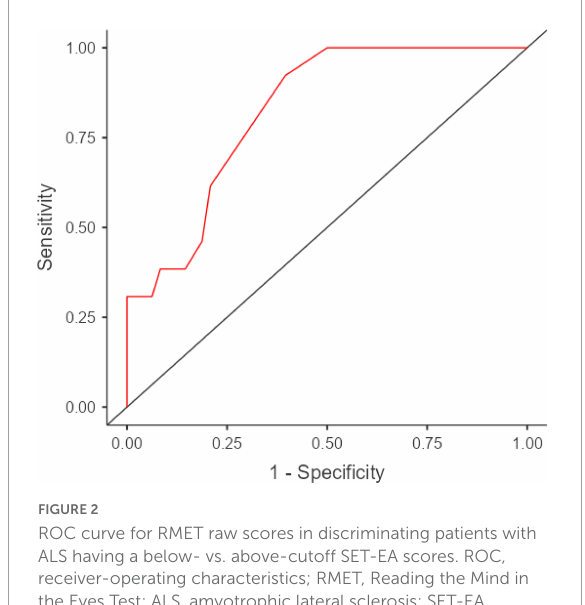
FIGURE2 ROC curve for RMET raw scores in discriminating patients with ALS having a below- vs. above-cutoff SET-EA scores. ROC, receiver-operating characteristics; RMET, Reading the Mind in the Eyes Test; ALS, amyotrophic lateral sclerosis; SET-EA, Story-Based Empathy Task-Emotion Attribution. AUC = 0.82; SE = 0.06; 95% CI [0.77, 0.93]. Visualization was performed using jamovi 2.3 (https://www.jamovi.org/) by means of the R package ROCR